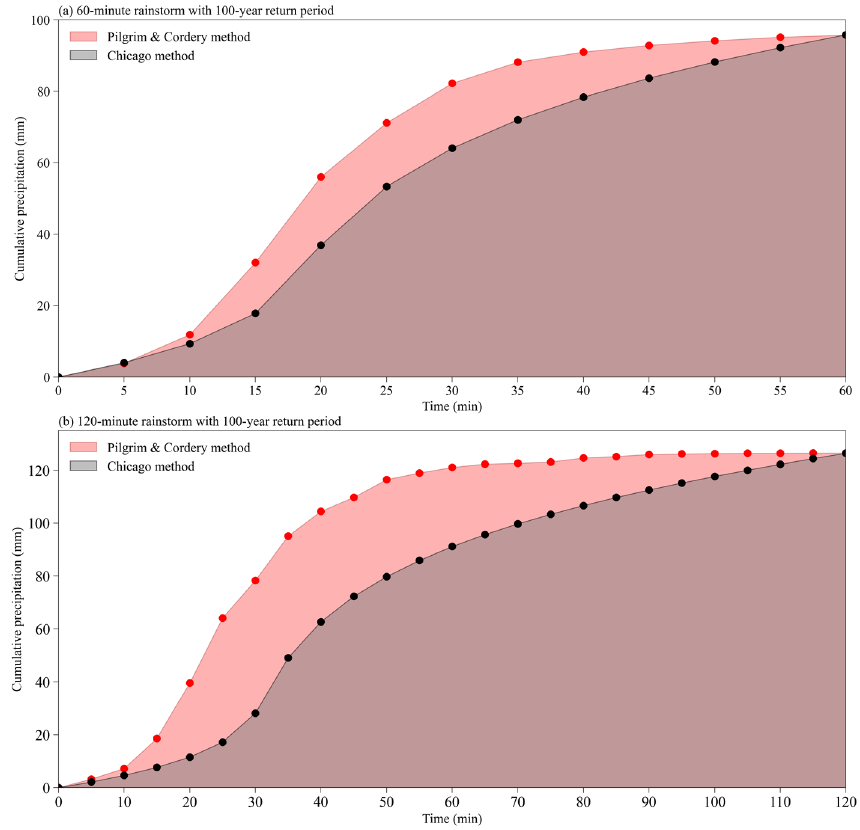
Figure 13. The storm patterns of rainstorms designed using PC method and Chicago method.